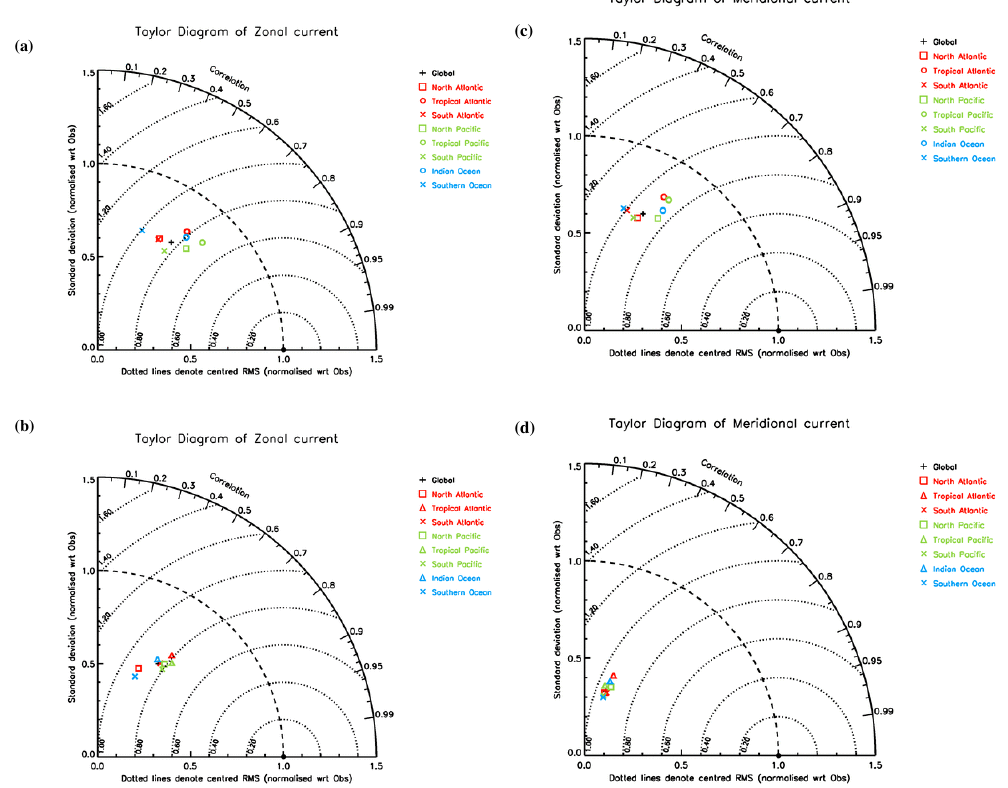
Fig. 3. Taylor plots showing the global drifter current validation for the FOAM V1 hindcast run (a) and for the drifter climatology (b) for zonal velocity. Corresponding Taylor plots for meridional velocity can be found in (c) and (d). Results are shown for the whole global ocean as well as the same sub-basin areas used in Table 2.